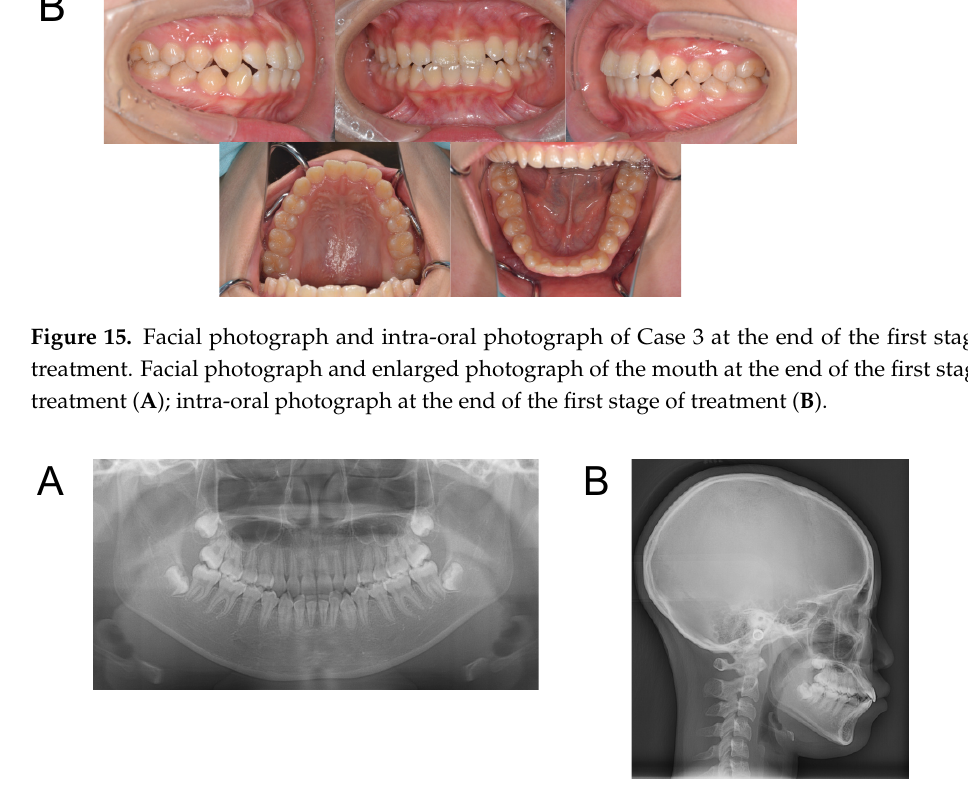
Figure 16. Panoramic radiograph ( A ) and lateral roentgenographic cephalogram ( B ) of Case 3 at the end of the first stage of treatment.